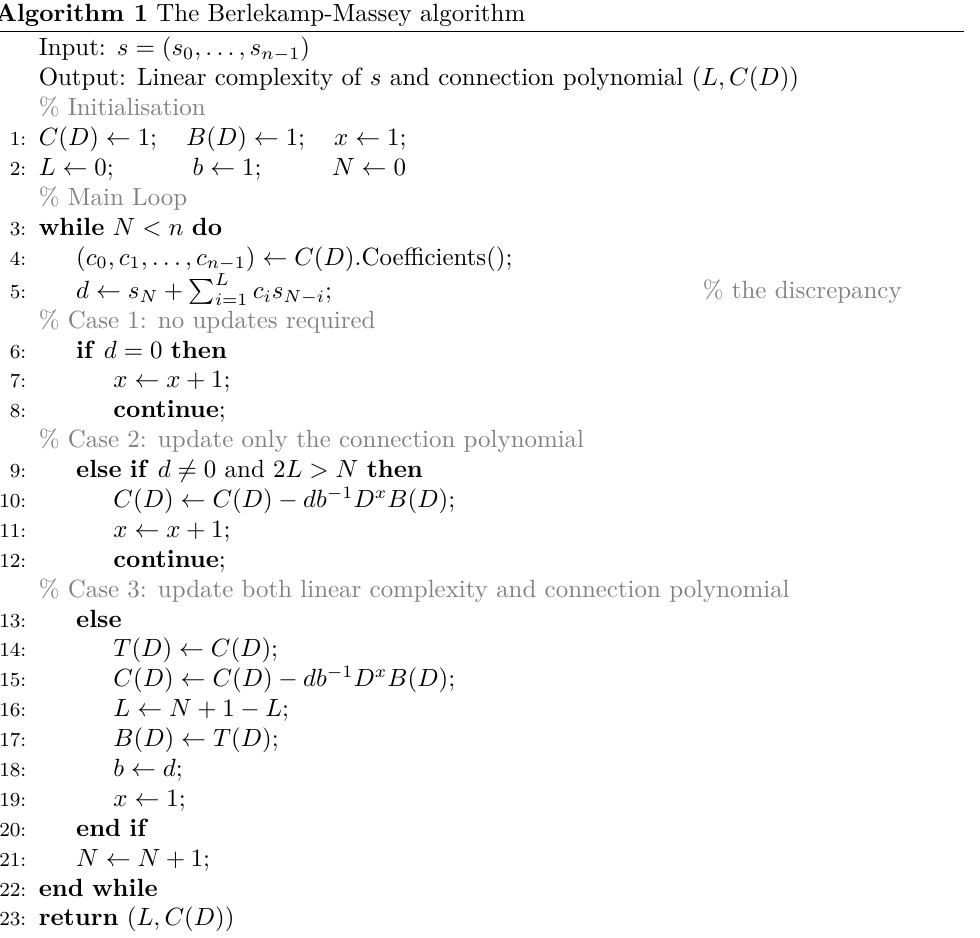
Algorithm 1 The Berlekamp-Massey